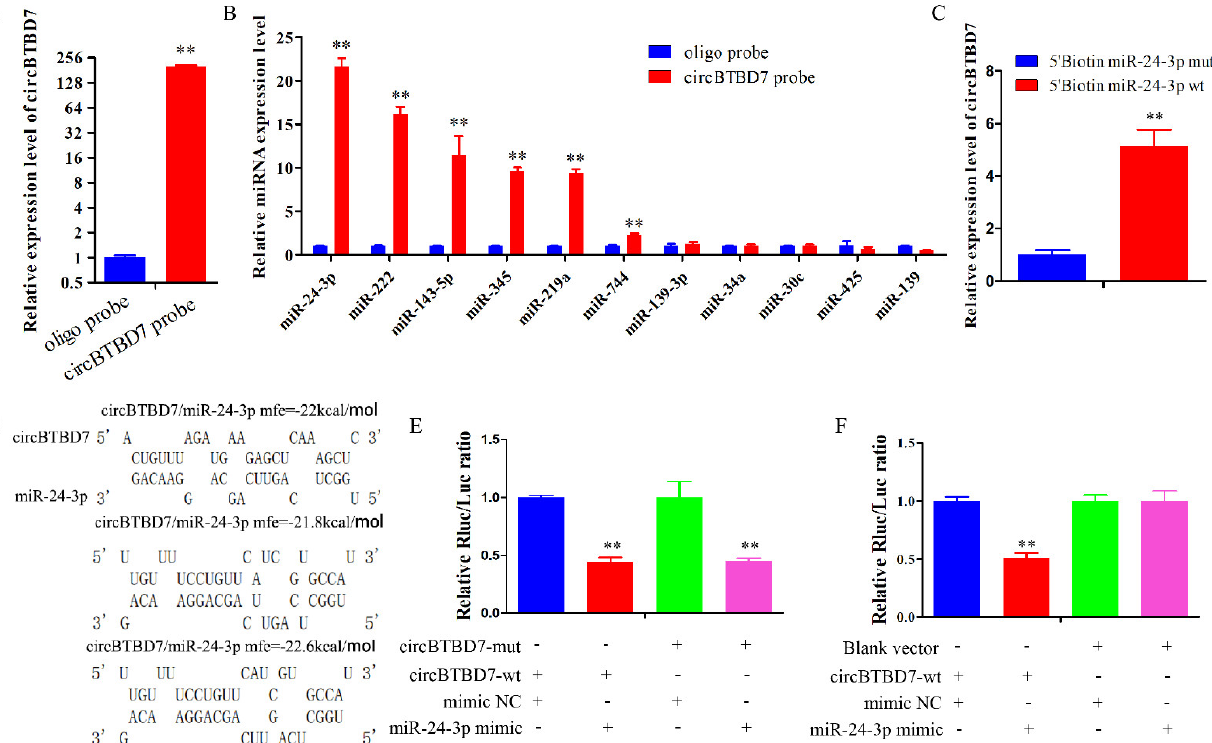
Figure 3. circBTBD7 acts as a sponge of miR-24-3p. ( A ) The efficiency of circBTBD7 probe used in RNA pull down assay was measured using the qRT-PCR assay ( n = 3). ( B ) Effect of circBTBD7 on the abundance of eleven potential miRNAs ( n = 3). The U6 gene was used as the internal control for qRT-PCR assay. ( C ) Effect of miR-24-3p on the abundance of circBTBD7 ( n = 3). ( D ) Predicted circBTBD7 binding sites to miR-24-3p. ( E , F ) Luciferase activity of four co-transfection cell groups in HEK293T cells ( n = 3). Data are presented as the mean ± S.D. ** p < 0.01.